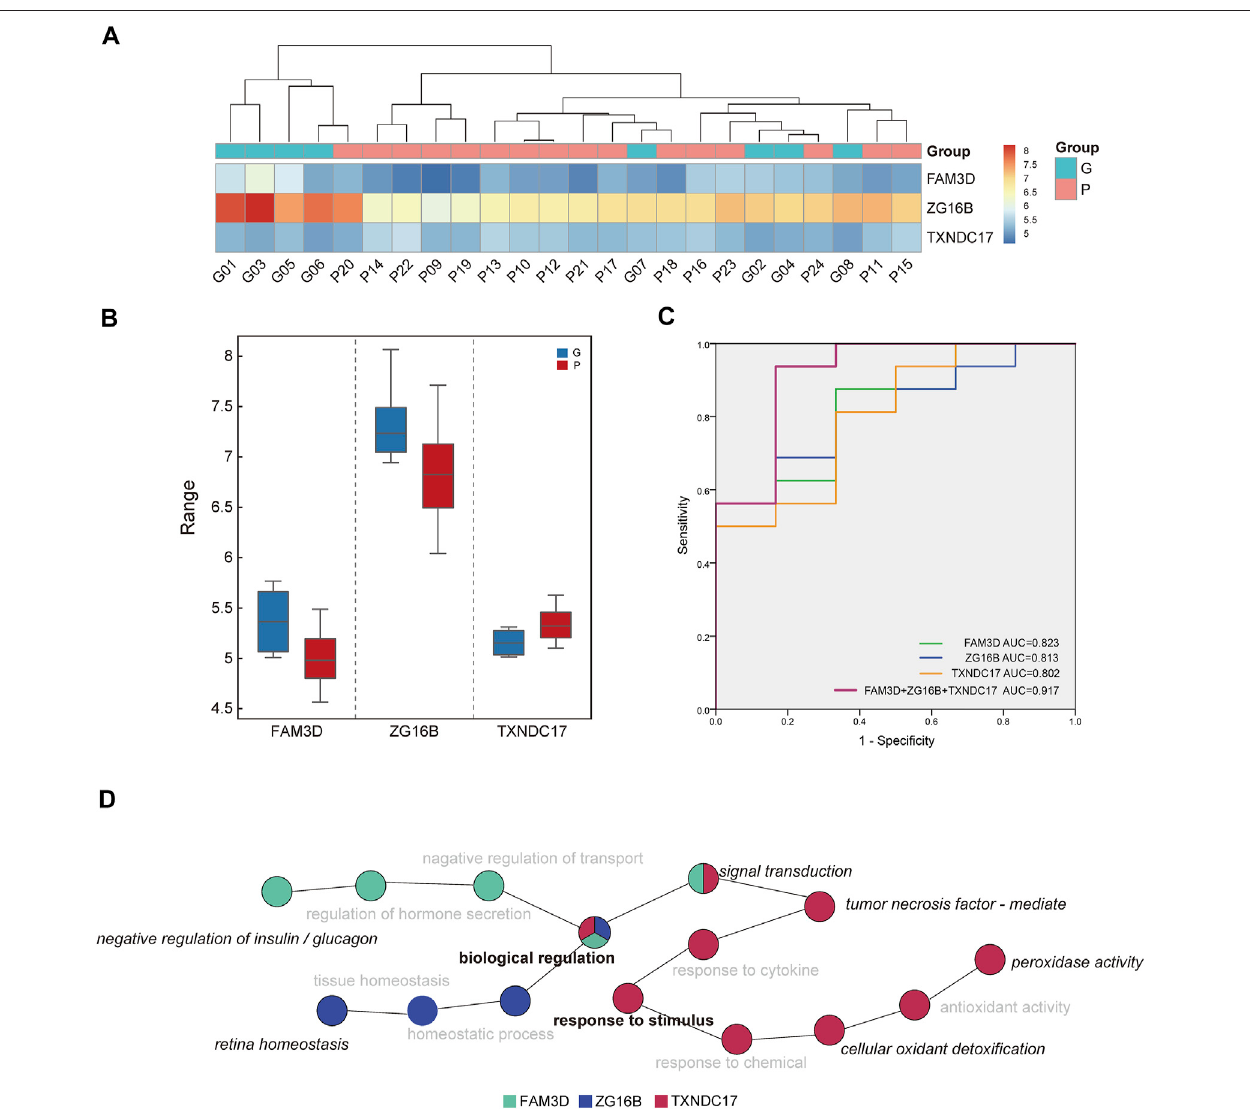
FIGURE 4 | Analysis of discriminating ability of candidate proteins. (A) The intensity-based heatmap indicates a partially clear separation of the two groups was observed.TherearefoursamplesofGgroupclosetoPgroupafterclustering. (B) TheboxdiagramshowsthecomparisonoftheexpressionlevelsofZG16B,TXNDC17, FAM3D between two groups. (C) Receiver operating characteristic (ROC) analysis of candidate proteins in saliva. The combination of three proteins revealed the best performance with an area under the curve of 917. (D) The diagram indicates the enriched biological process of three proteins in saliva. Biological regulation and response to stimulus were in the central position, and other speci fi c annotated functions include negative regulation of insulin and glucagon, retina homeostasis, peroxidase activity, etc.